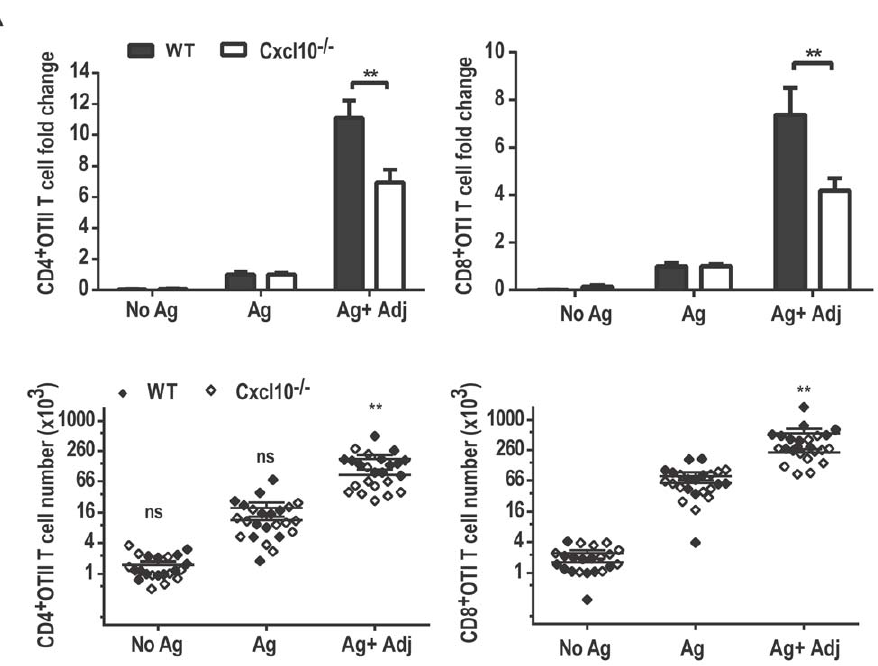
Figure 4. Impaired Lipid A induced adjuvant effects on T cells in CXCLl10 2 / 2 recipients. OTI and OTII T cells were activated in WT vs. CXCL10 2 / 2 recipients with subcutaneous hock injections containing antigen alone (Ag), antigen plus lipid A (Ag + Adj) or saline (No Ag). Spleens from recipient mice were harvested 96 h after immunization and OTI and OTII T cells were enumerated by flow cytometry. The ratios of OT and OTII cells recovered from the adjuvant treated mice vs. antigen treated mice are plotted as a fold change (A) and in absolute numbers (B). Data are from three independent experiments combining with 3 replicates in each experiment (n=9). **;P value , 0.001.